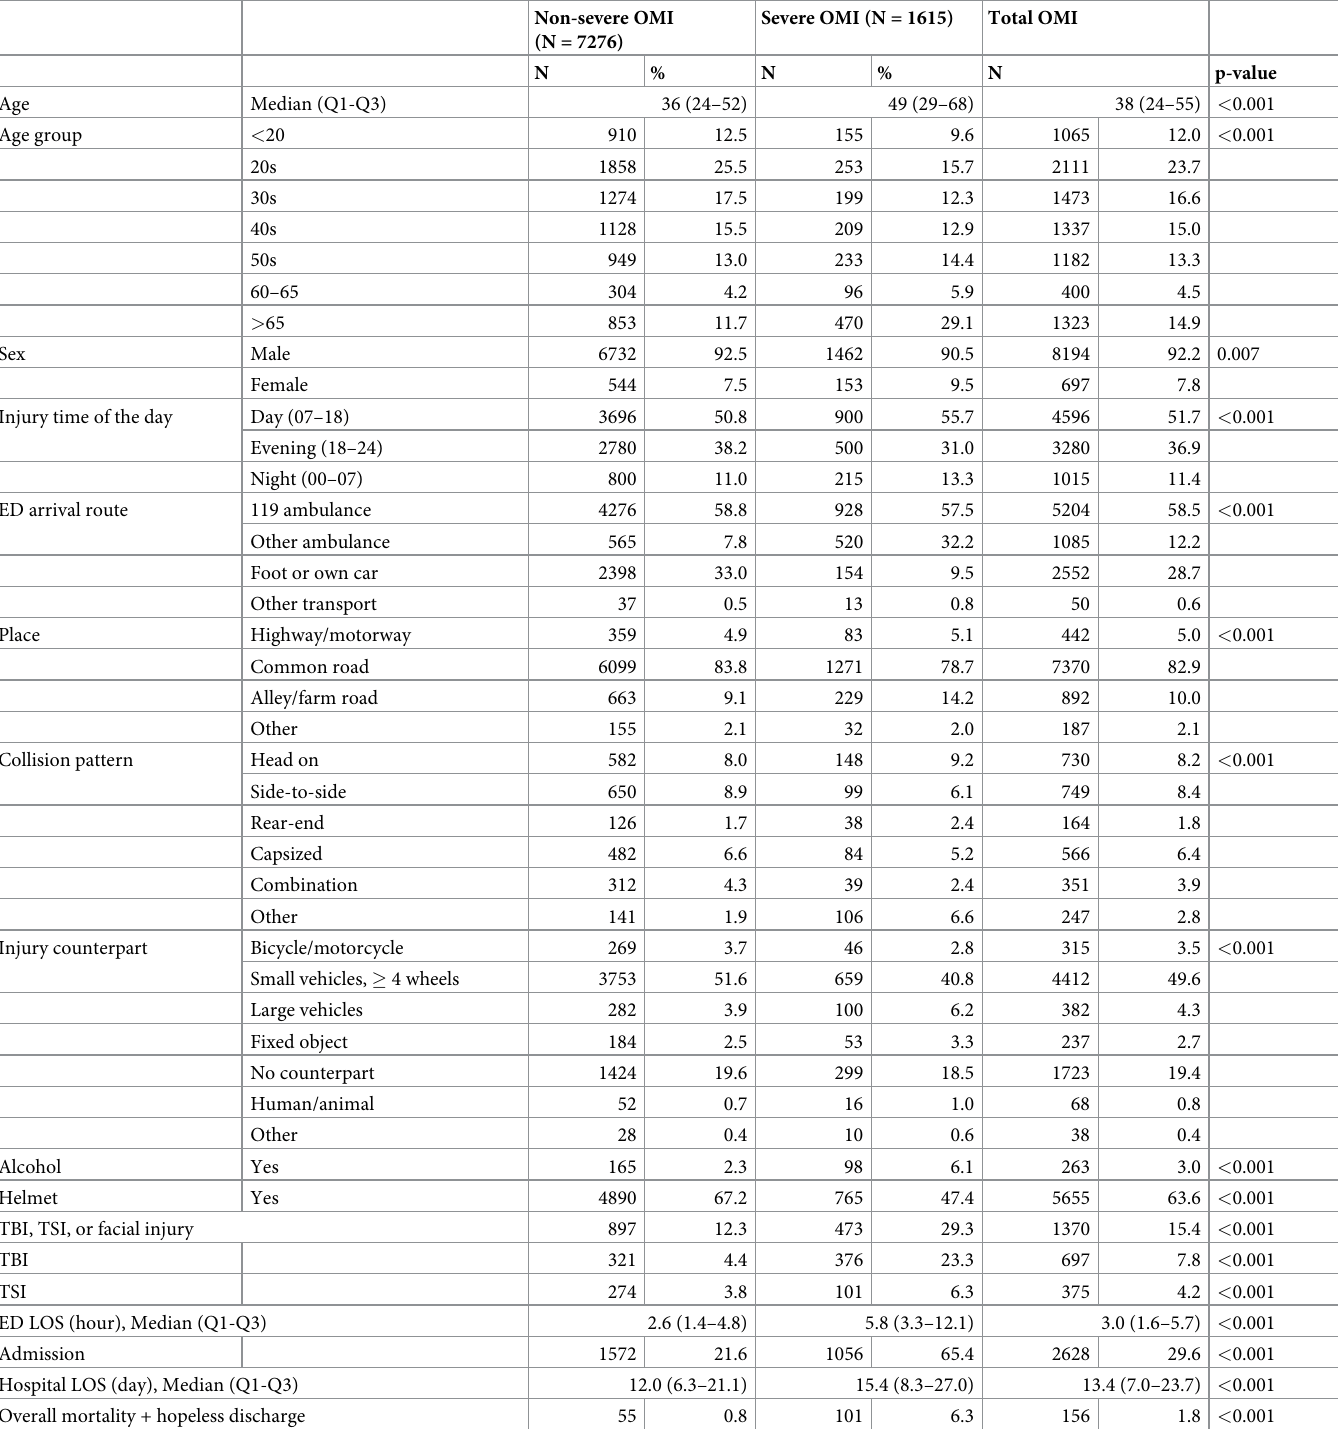
Table 2. General characteristics, injury detail, and clinical results of occupational motorcycle injury cases in the study period, according to